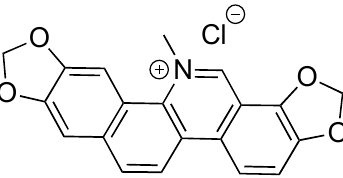
Figure 11. Sanguinarine chloride, a natural product from bloodroot Sanguinaria canadensis .